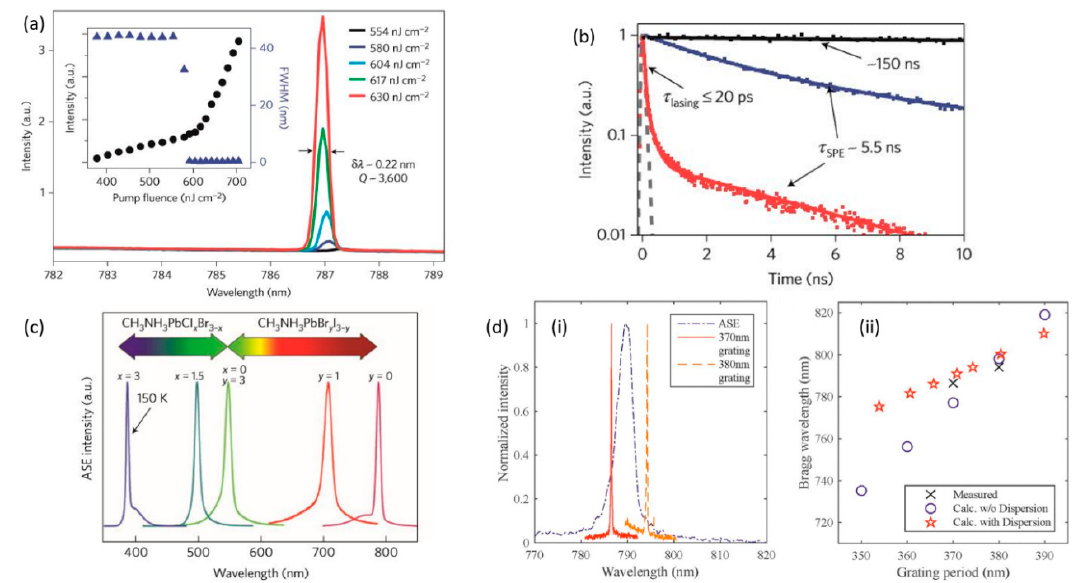
Figure 4. ( a ) Nonlinear increase of the output intensity beyond the laser threshold point; A spectral linewidth shrinking above threshold is also observed as a clear indication of the onset of the laser operation. ( b ) The transition from the spontaneous emission to stimulated emission is depicted on the reduction of the PL signal above threshold as the Time Resolved Photoluminescent measurements indicate. Reproduced with permission from Zhu et al. [27], Nature Materials; published by Nature Publishing Group, 2015. ( c ) Coarse Tunability of the emission laser light achieved through the halide constitution (controllable stoichiometry). Reproduced with the permission from Xing et al. [13], Nature Materials; published by 2014 Macmillan Publishers Limited ( d ) Fine wavelength tuning using different grading periods in a DFB configuration: ( i ) amplified spontaneous emission spectrum and lasing spectra and ( ii ) calculated and measured Bragg wavelengths. Reproduced with permission from Brenner et al. [31], Applied Physics Letters; published by AIP Publishing.